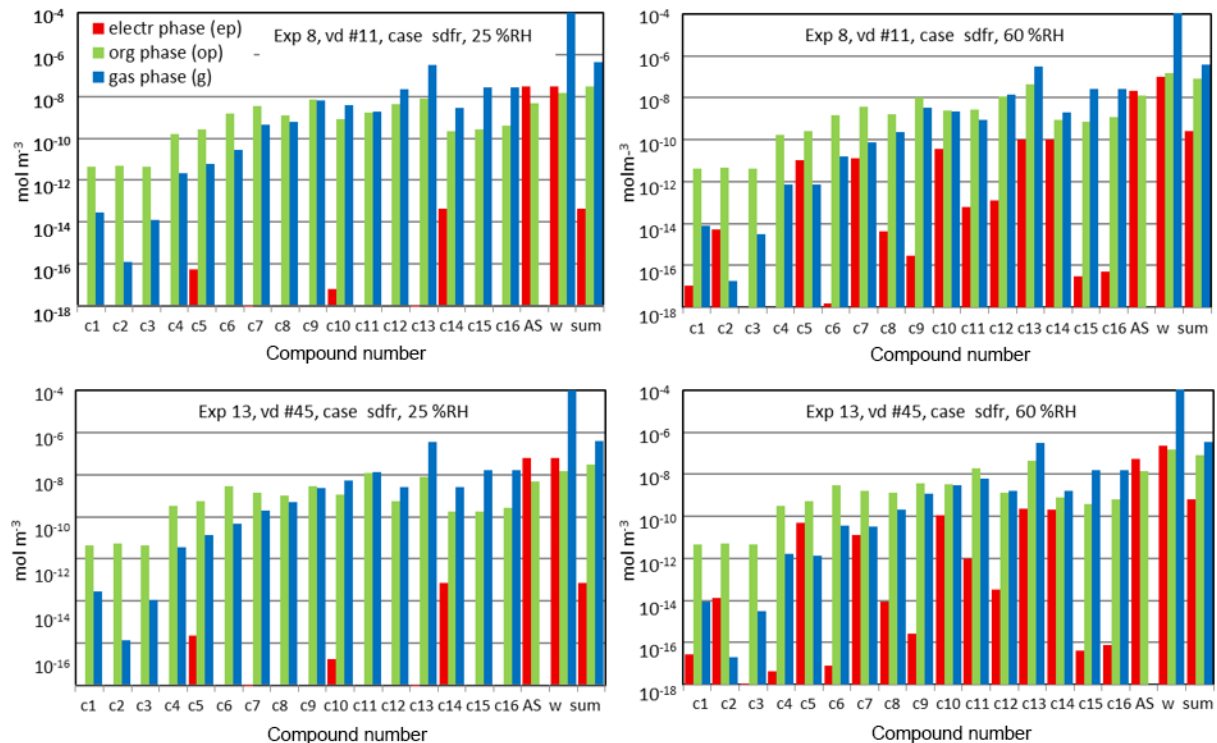
Figure 9. Equilibrium phase partitioning (molm − 3 ) for case sdfr between gas phase, electrolyte phase, and organic phase at low RH (25%) and at high RH (60%) for experiment 8, volatility distribution 11 (upper panels) and experiment 13, volatility distribution 45 (lower